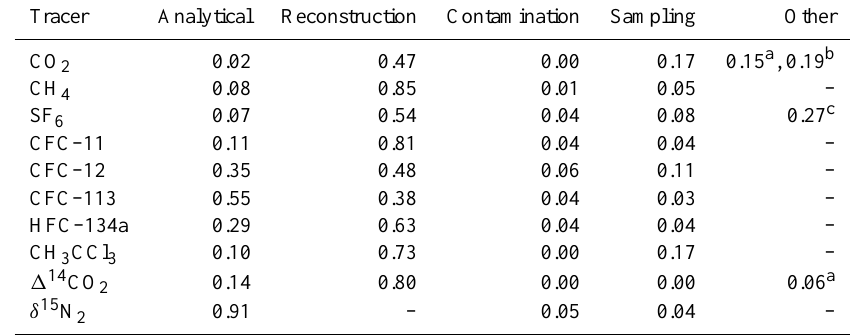
Table 2. Relative contributions to the total uncertainty, averaged over the firn column (EU borehole). Tracer